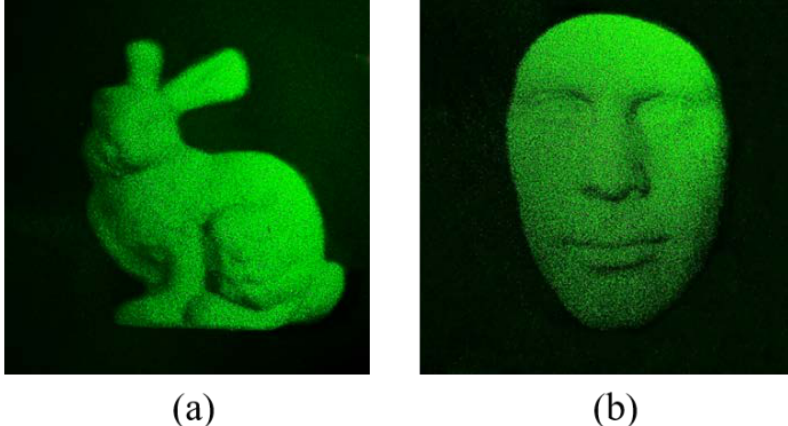
Figure 10. Optical reconstruction experiment.